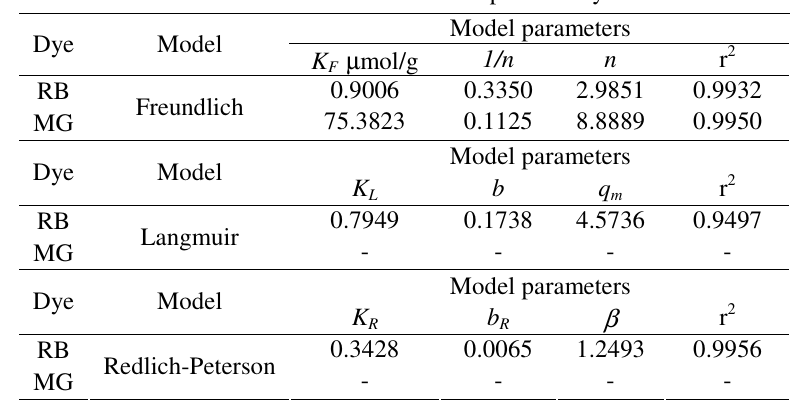
Table 7. Isotherm constants for adsorption of Dyes at 60 ° C